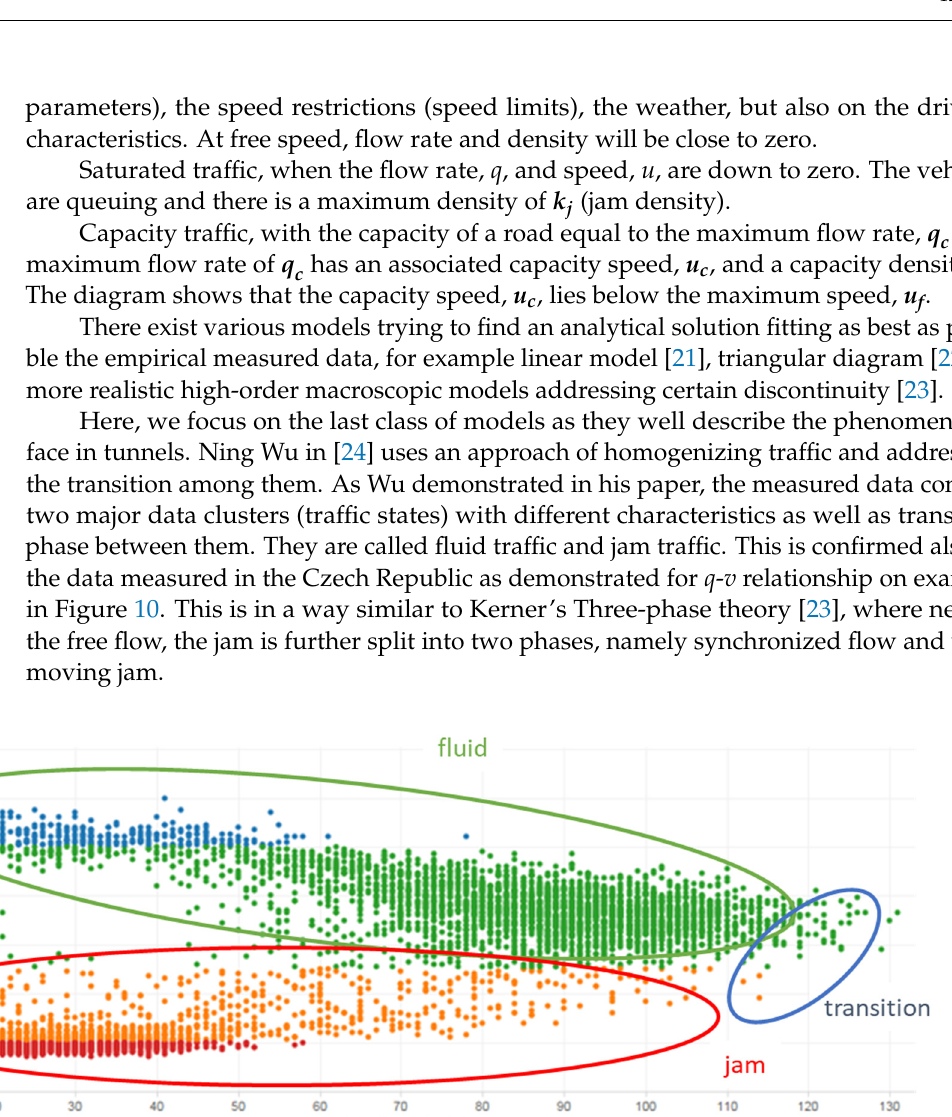
Figure 11. The hysteresis within transition phase between fluid and jam traffic. For the purpose of this paper and the road urban tunnel control system, it is clear from the above-mentioned theory that we need to focus on density. We are mainly inter- ested in the point when the fluid traffic breaks into the jam, that is at density 𝜅 (cid:3012)(cid:3016) (i.e., at the state that the average length of the net headways between the vehicles is equal to 𝜏 (cid:3012)(cid:3016) in the fluid convoy). The jam traffic turns back upwards into the fluid traffic at 𝜅 (cid:3034)(cid:3042),(cid:3040)(cid:3036)(cid:3041) (i.e., at the state that the average length of the net headways between the vehicles is equal to 𝜏 (cid:3034)(cid:3042) in the jam convoy). For more details on identifying the critical values of density, refer to Wu [24].